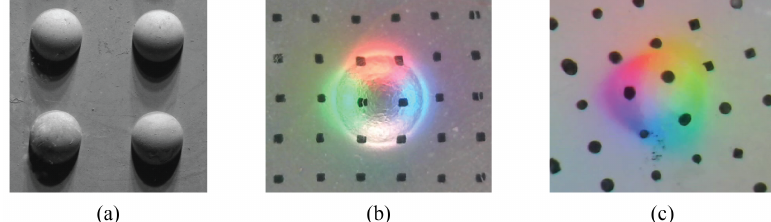
Figure 6. Calibration images (part) with different GelSight sensors. During calibration, a ball/ball array is pressed on the sensor, and the image intensity change corresponds to the surface normal of the ball. ( a ) the calibration image of the side-illuminated GelSight device [8] (Got copyright permission from Association for Computing Machinery), under the single-colored illumination from one direction; ( b ) the calibration image of the first fingertip GelSight sensor [28] (Got copyright from MIT), where the illumination has four colors; ( c ) the calibration image of the improved fingertip GelSight [29] (©2017 IEEE), where the illumination has three colors. For ( b , c ), we press the ball at different locations, and take the average color change value to surface